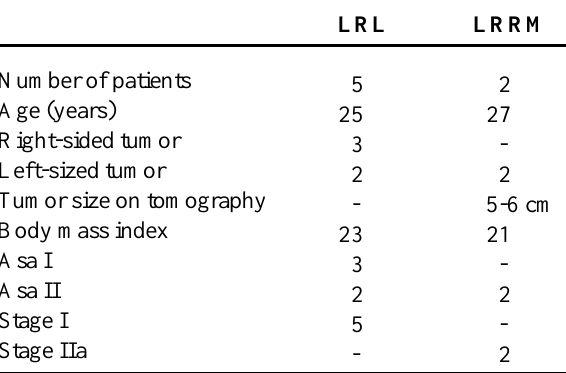
Table 1 – General demographic data of patients who un- derwent laparoscopic retroperitoneal lymphadenectomy (LRL) for staging and laparoscopic resection of residual mass